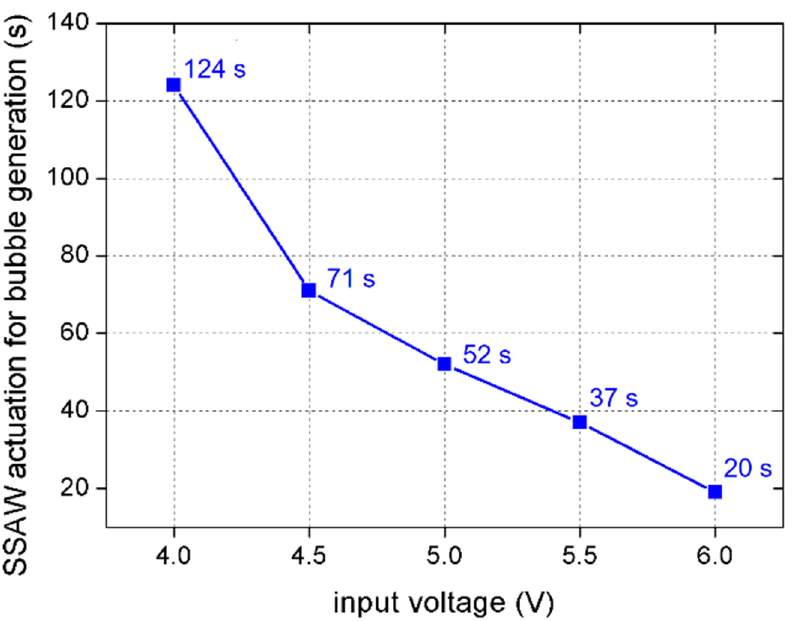
Figure 6. SSAW actuation time for generation of the first bubble at different input voltage.